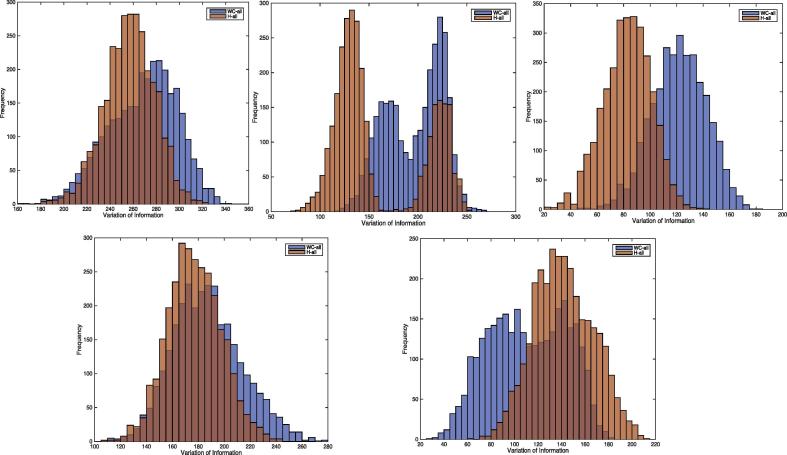
VI distribution for WC_all (blue) and H_all (orange). 1st row (left to right): Patient 1, 2 & 3; 2nd row (left to right): Patient 4 & 5. The values for the null distribution are: mean = 408.60 and SD = 49.29. (For interpretation of the references to color in this figure legend, the reader is referred to the web version of this article.)